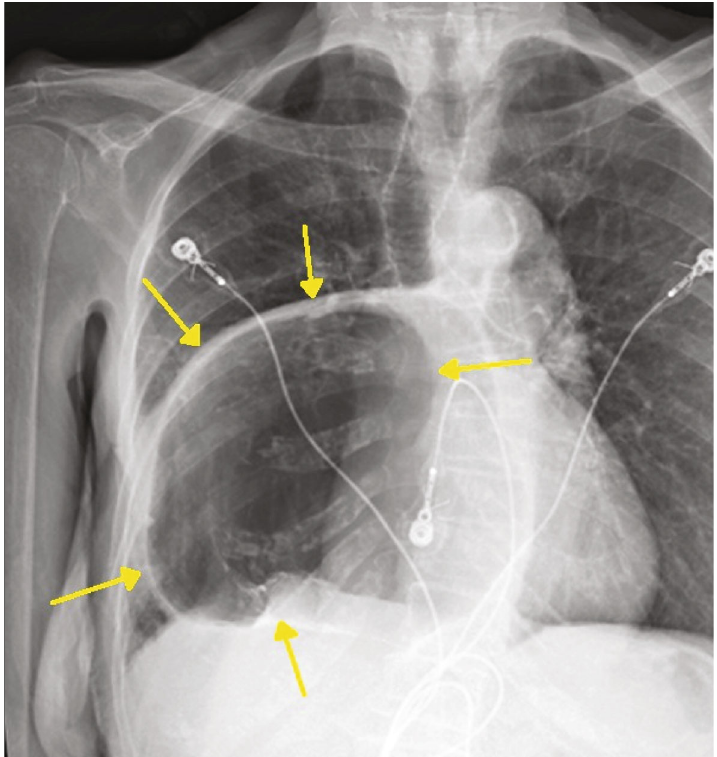
Figure 1: Upright chest X-ray showing large intrathoracic hiatal hernia between the yellow arrows.